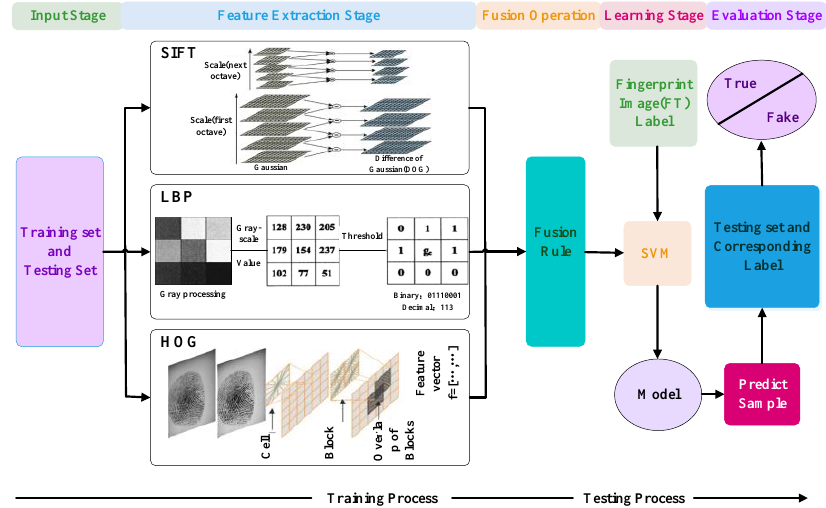
Figure 1. Flow chart of fingerprint liveness detection based on fine-grained feature fusion.